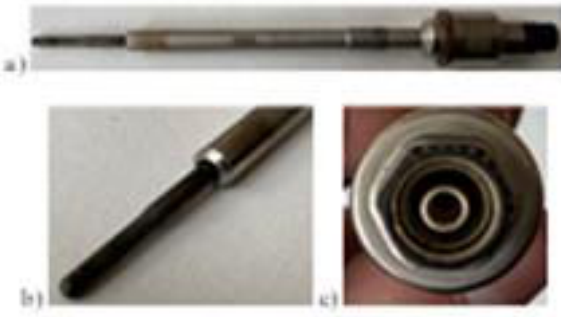
Fig. 3. The failed glow plug from the Opel Insignia 2014 2.0 CDTi engine (source: own